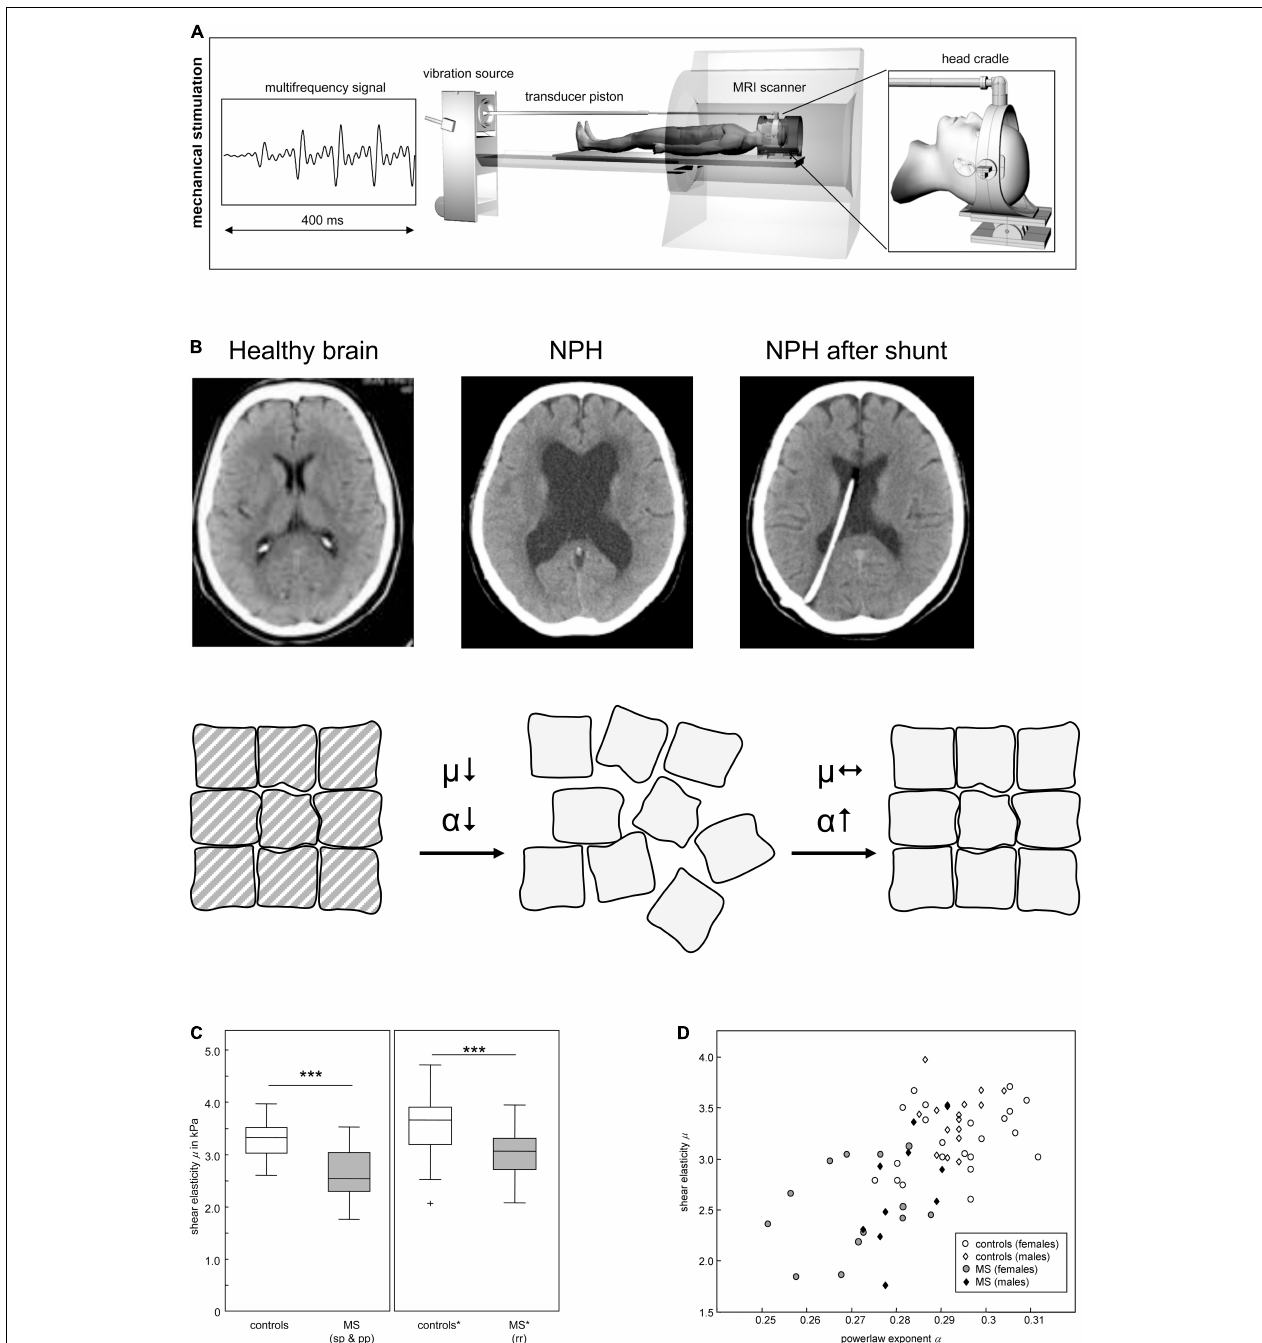
FIGURE 2 | Mechanical properties in neurodegeneration. (A) Scheme of cerebral multifrequency MRE. The MRI scanner is combined with a device for acoustical head stimulations comprising a signal generator that produces a multifrequency signal composed from four harmonic frequencies of 25, 37.5, 50 and 62.5 Hz; a loudspeaker to generate acoustic vibrations; an extended piston that transfer the vibrations into the scanner and a head cradle to stimulate head vibrations mainly along the head-feet direction. (B) Cerebral MRE of NPH brains reveals a disease related decreased stiffness ( µ ), which is not recovered after surgical treatment. In contrast α increases after 3 months, to almost symptomatic values, suggesting that the topology of the tissue’s matrix is reorganized although its strength remains diminished. Reprinted with kind permission from Springer Science and Business Media from Freimann et al. (2011). (C) Reduction of brain elastic properties in healthy volunteers and multiple sclerosis (MS) patients. sp, secondary progressive; pp, primary progressive; rr, relapsing remitting. (D) Viscoelastic constants for prediction of brain pathology. Individual data of shear elasticity and power law exponent of brain of healthy volunteers and MS patients are represented. Panels (A,C,D) reprinted with kind permission from Springer Science and Business Media from Streitberger et al. (2012). Panel (B) reprinted with kind permission from Nature Portfolio from Yamada et al. (2019).